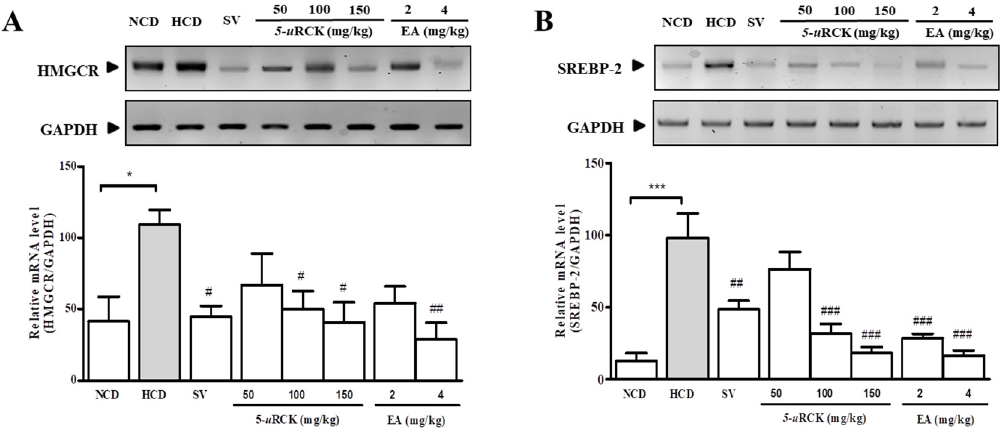
Figure 7. Effects of 5- u RCK or ellagic acid (EA) on the expression of HMGCR and SREBP-2 in the livers of rats fed an HCD. Relative mRNA expression of 3-hydroxy-3-methyl-glutaryl-CoA reductase (HMGCR) ( A ) and SREBP-2 ( B ) was analyzed after 5- u RCK or ellagic acid treatment for five weeks. The gene expression levels were quantified by qPCR. Experiment was repeated independently three times ( n = 6–8 rats per group each time) and the RT-PCR product is representative of one of them. Each bar graph represents the mean ± SD of 6–8 rats per group ( n = 6–8 rats/group, 3 times repeat). P values for comparisons with control groups (NCD groups) are denoted as * p < 0.05 and *** p < 0.001, and those for comparisons with HCD groups are denoted as # p < 0.05, ## p < 0.01, and ### p < 0.001.